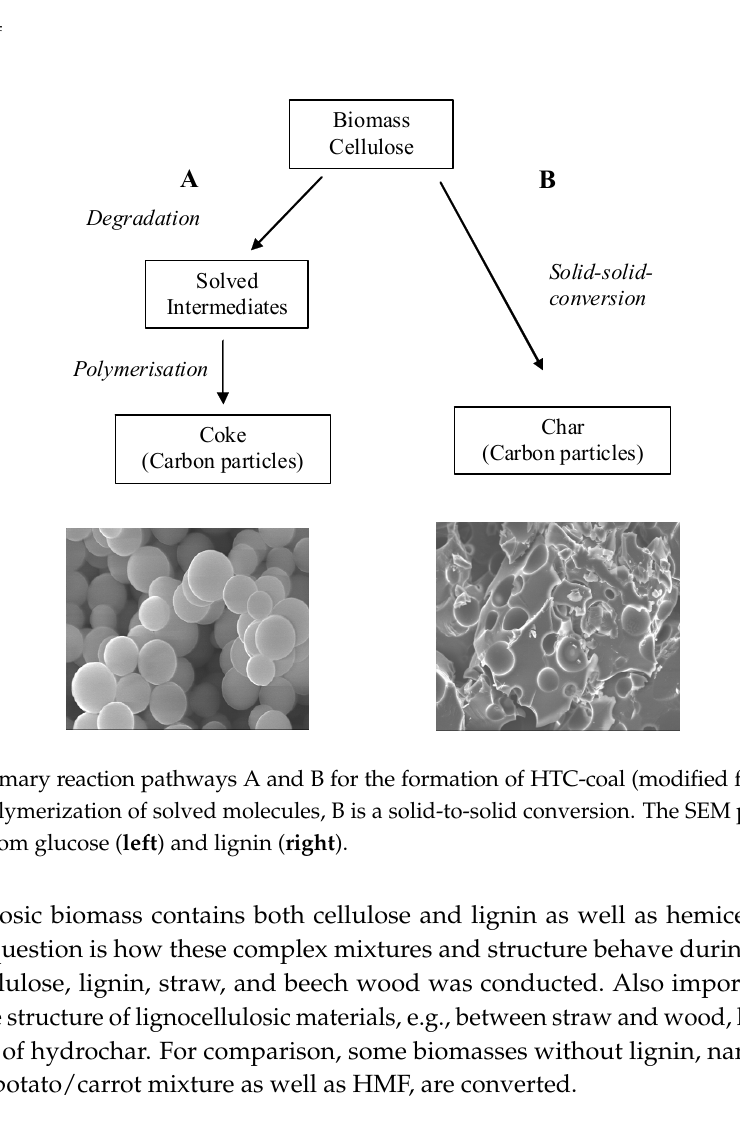
Figure 2. Structure of lignocellulose. Reproduced from Ref. [10] with permission from The Royal Society of Chemistry.